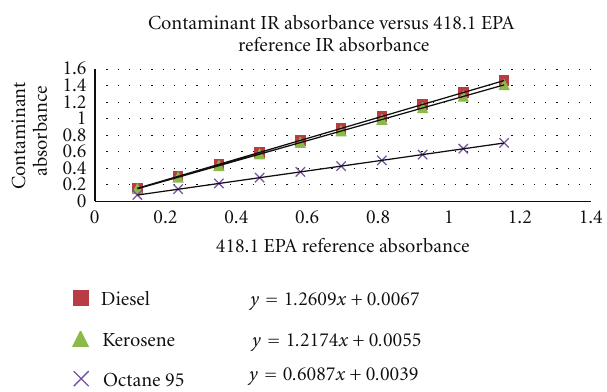
Figure 2: Contaminant IR absorbance versus 418.1 EPA reference IR